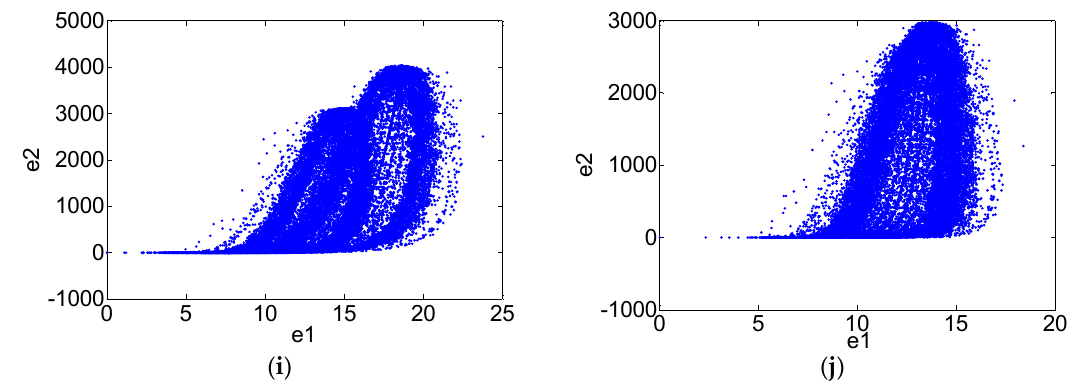
Figure 9. Chaotic dynamic error path showing no islanding. ( a ) α = 1 ( b ) α = 0.9 ( c ) α = 0.8 ( d ) α = 0.7 ( e ) α = 0.6 ( f ) α = 0.5 ( g ) α = 0.4 ( h ) α = 0.3 ( i ) α = 0.2 ( j ) α = 0.1.